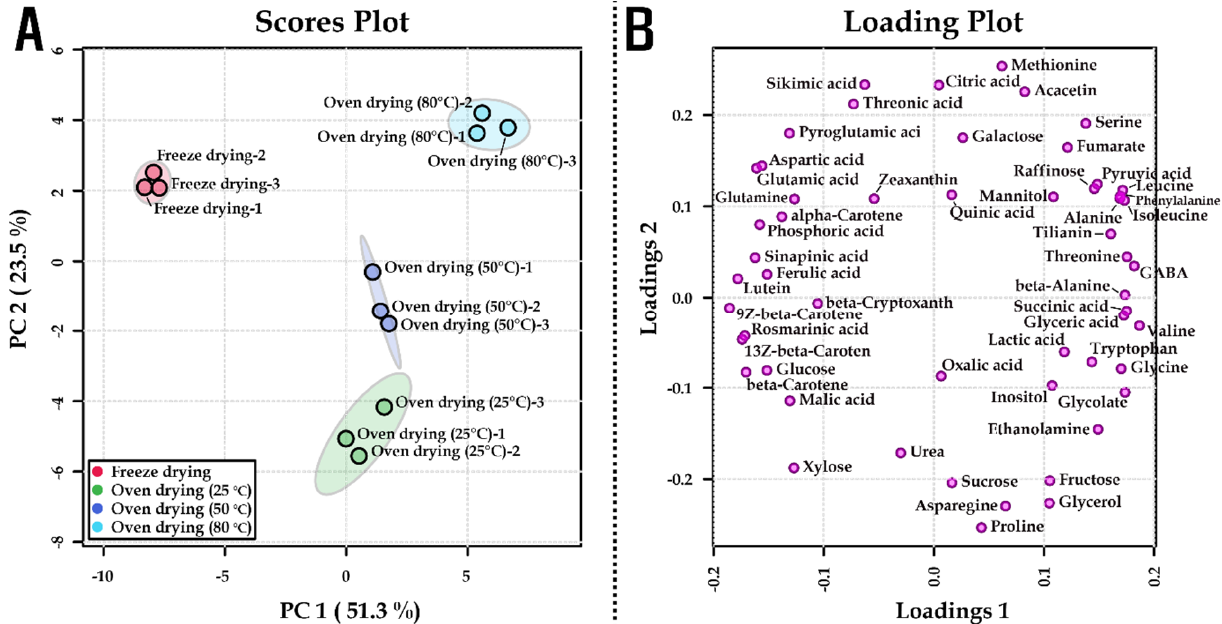
Figure 2. ( A ) Score plots of principal components 1 and 2 of PCA results obtained from metabolites of Agastache rugosa at different drying temperatures. ( B ) Loading plots of principal components 1 and 2 of PCA results obtained from metabolites of Agastache rugosa at different drying methods.